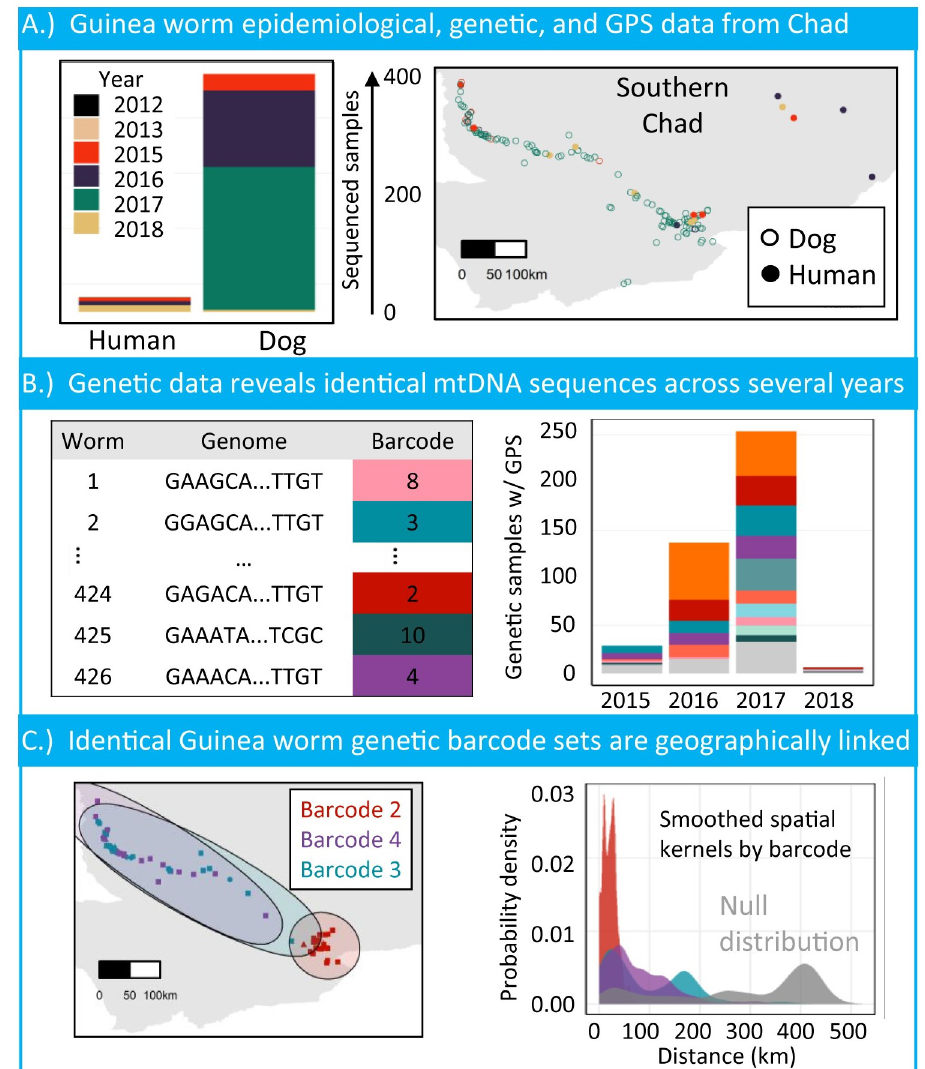
Fig 1. Characteristics of genetically characterized Guinea worm cases in Chad from 2012–2018. A.) Number of cases per host species collected from 2012–2018, with GPS matched sample distributions across the Chari River. Chad maps were generated with GADM data. B.) The number of GPS matched samples that belong to barcode sets. Note, not all barcode colors are shown in the left figure. Barcodes with less than 10 samples in the population are colored in light gray for visual clarity. C.) Samples belonging to barcode sets 2, 3 and 4 are shown in their respective ranges. Smoothed kernel densities for the three barcode sets show the mass of the distributions correlate with the spatial connectedness of